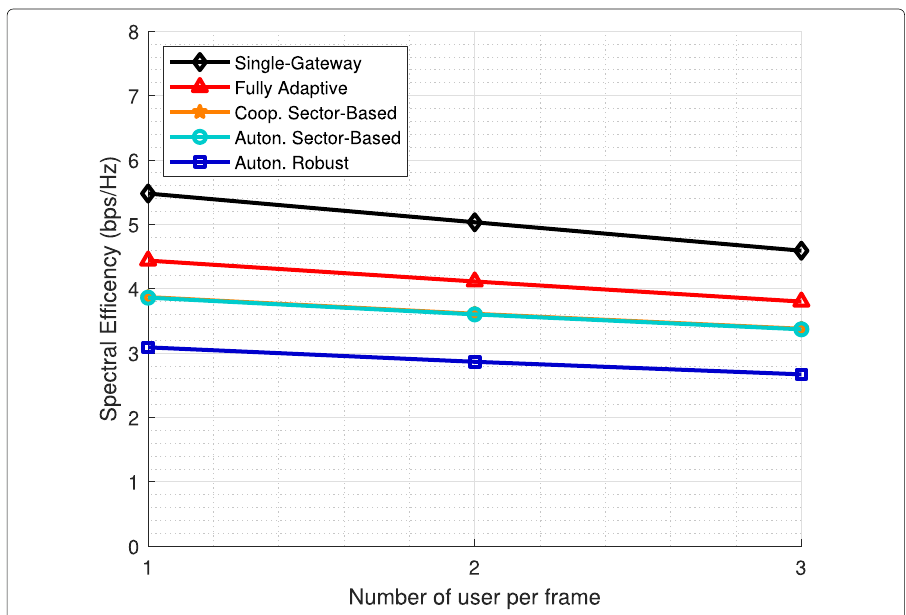
Fig. 13 Multicast performance for different number of users per frame. SNR = 20 dB